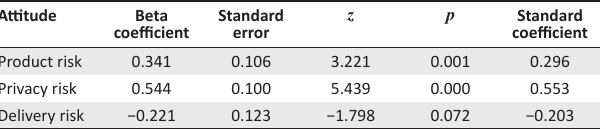
TABLE 4: Regression Model 1 – Risk factors and attitude.